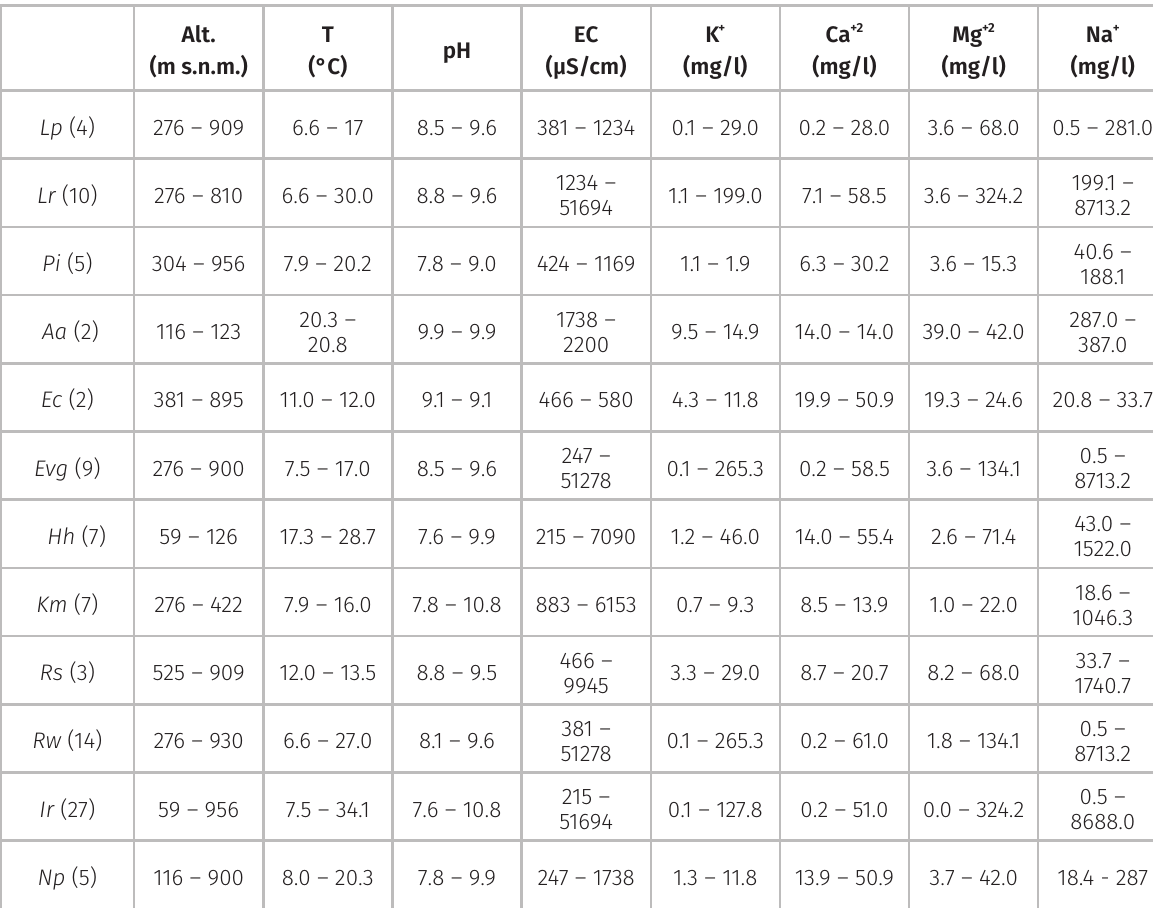
Table III. Tolerance range of endemic species for the examined parameters, number of occurrences in parenthesis. Abbreviations: Alt. = altitude, T = temperature, EC = electrical conductivity. For species abbreviation see Table